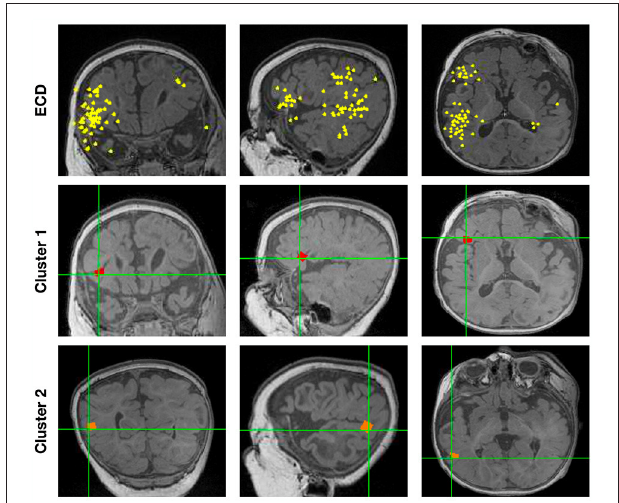
FIGURE 5 | The localization results for one patient (Subject 16) with spikes in two clusters by ECDss and by Champagne algorithm.